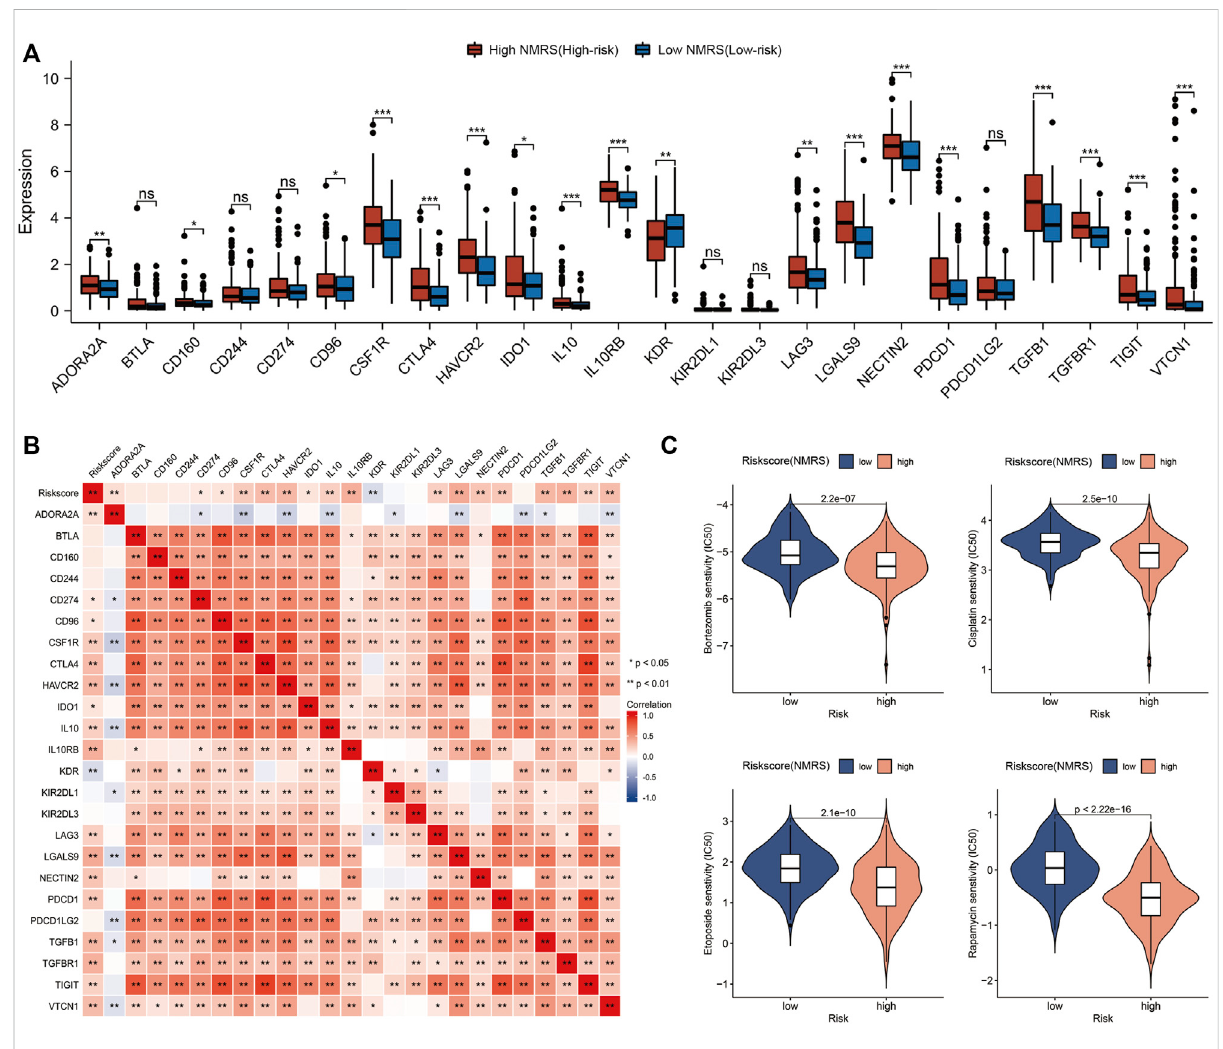
FIGURE 6 Immunecheckpointanalysisandchemotherapydrugprediction. (A) Differencesintheexpressionofimmuneco-inhibitorymoleculesbetween high patients and low NMRS patients. (B) Correlation analysis of NMRS with immune co-inhibitory molecules. (C) Screening of sensitive chemotherapeutic agents in the high NMRS